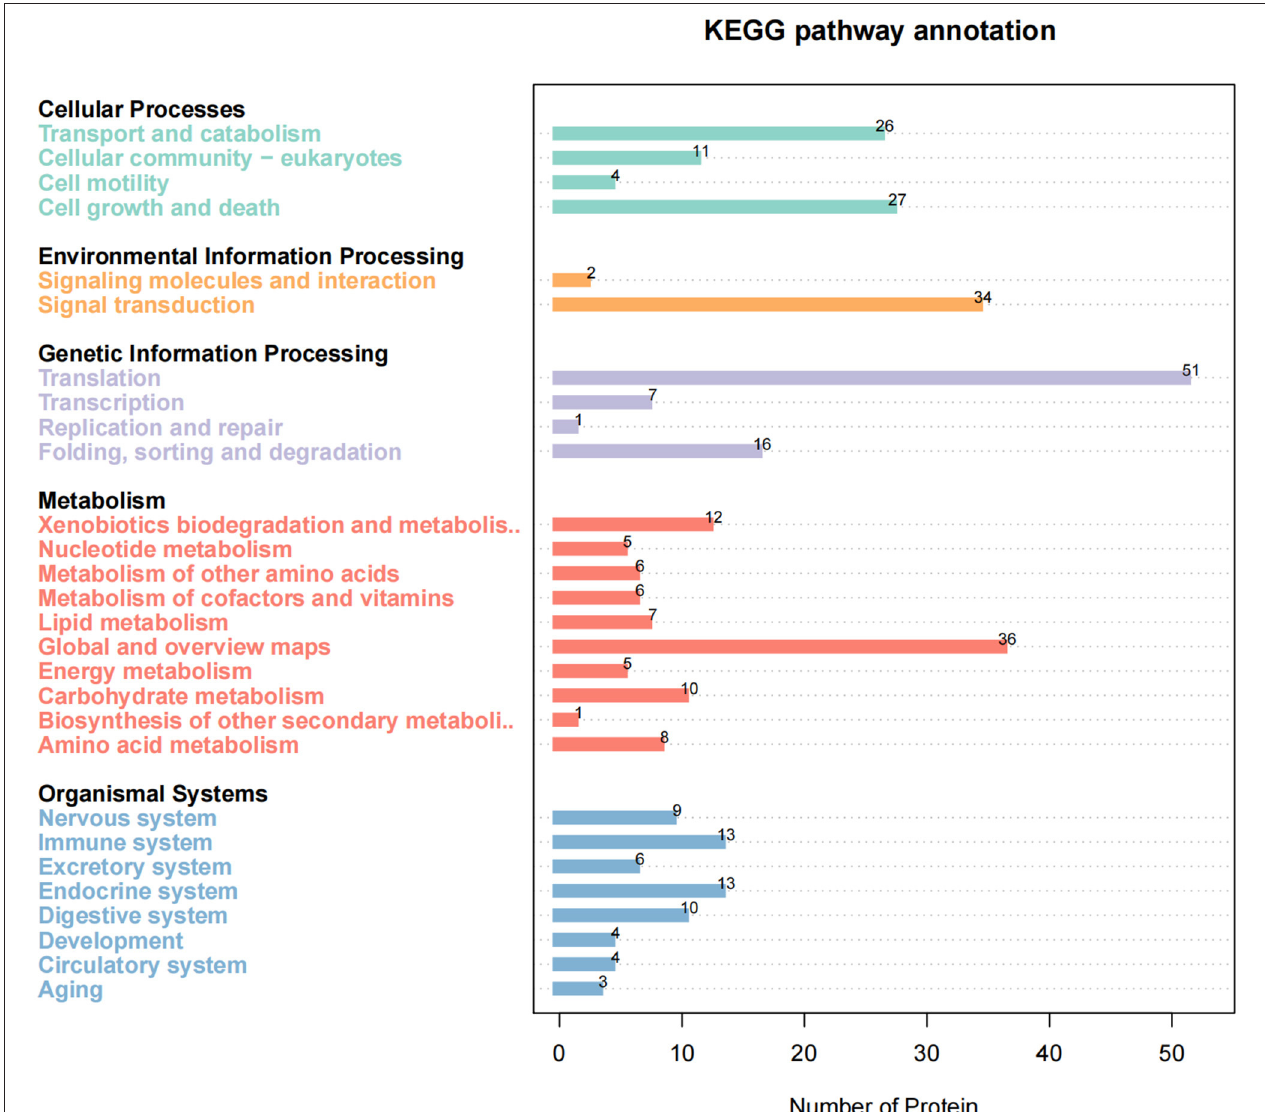
FIGURE 4 | KEGG pathway enrichment analysis. The enriched pathways targeted by Swine acute diarrhea syndrome coronavirus (SADS-COV)-M-interacting proteins were analyzed using the Kyoto Encyclopedia of Gene and Genomes (KEGG) functional annotation pathway database. The terms that were significantly enriched ( p < 0.05) were